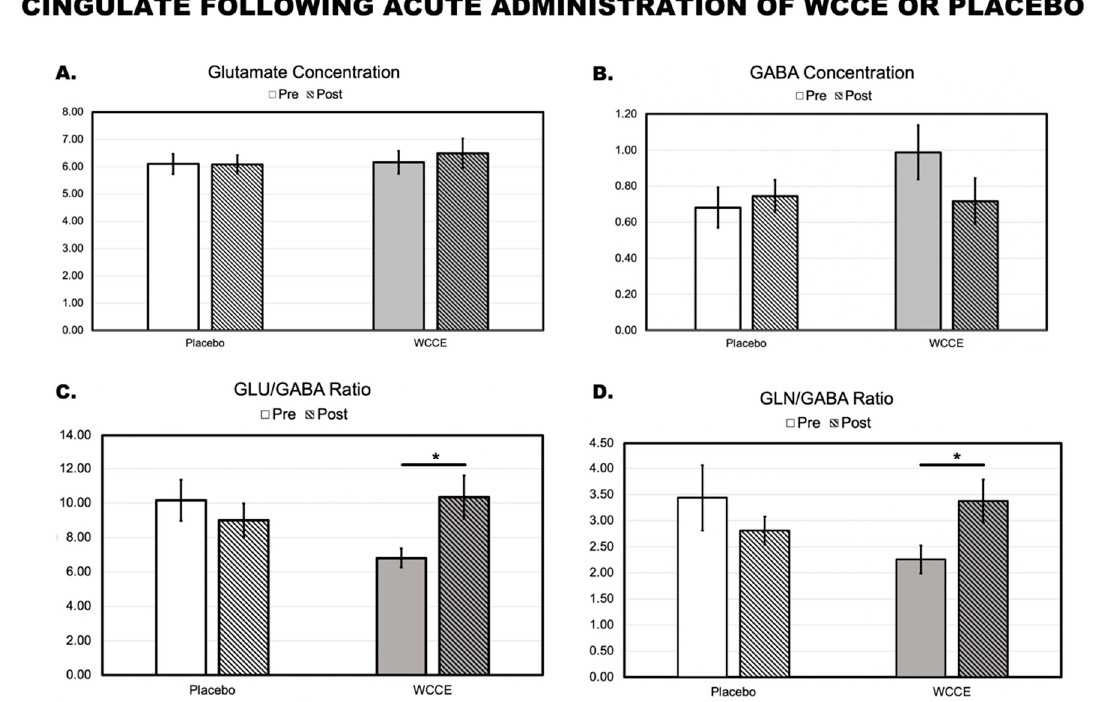
Figure 6. Bar graph with M ± SEM demonstrating the changes in glutamate, gamma-aminobutyric acid (GABA), and the ratios of glutamate/GABA (GLU/GABA) and glutamine/GABA (GLN/GABA) within the anterior cingulate cortex following the administration of either the placebo or WCCE. Y-axis units of measurement are institutional units. A * indicates significance at the p < 0.05 level for one-tailed t -tests. For descriptive data, please see the supplemental table hosted at https://osf.io/qypr8/. Clear bars represent the placebo, while gray bars represent WCCE. Striped bars indicate post-meas- urements.